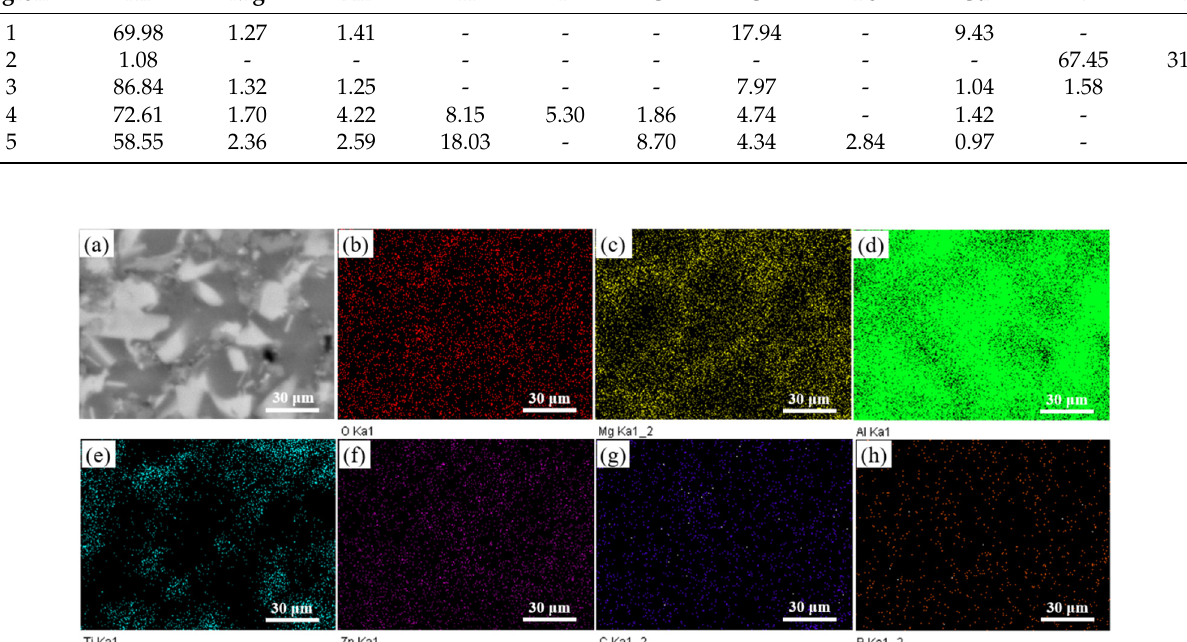
Figure 2. Alloying elements distribution of 20 wt.% TiB 2 -TiC x /7075 composites. ( a ) micromorphology; ( b ) O; ( c ) Mg; ( d ) Al; ( e ) Ti; ( f ) Zn; ( g ) C; ( h ) B.